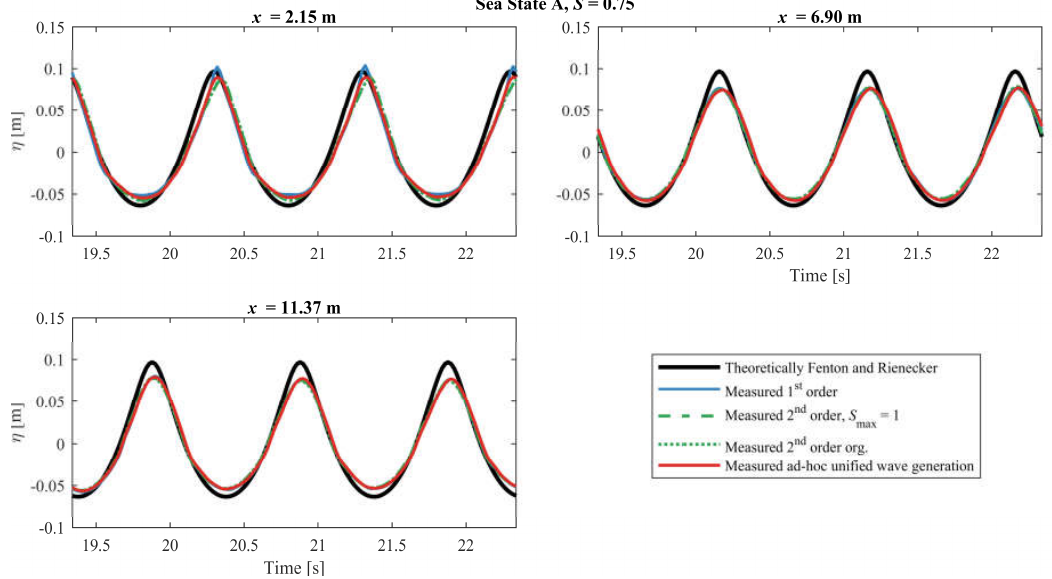
Figure 5. Theoretically surface elevation compared with the first-order, second-order, modified second-order and the ad-hoc unified wavemaker methods for Sea State A.